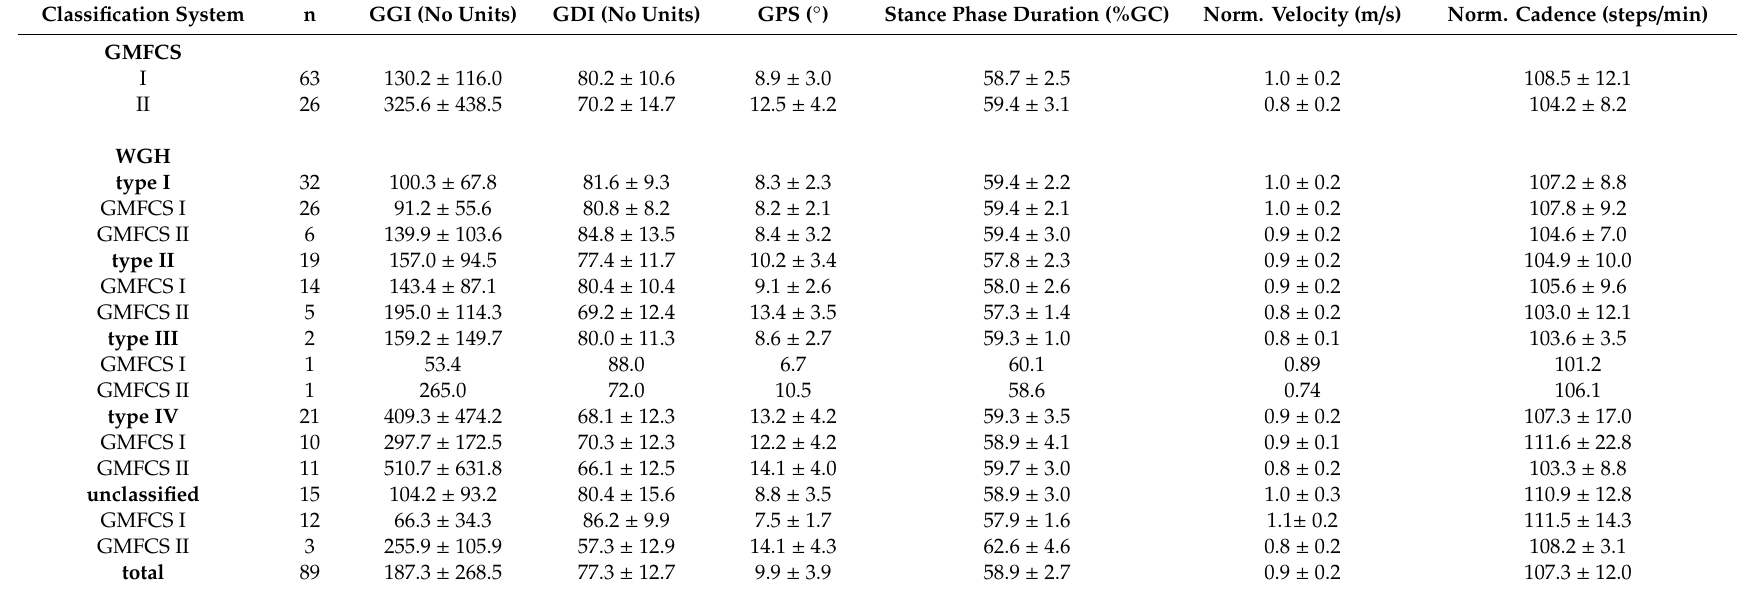
Table 1. Descriptive statistics. Subgroup-specific mean values of the di ff erent gait indices and mean spatiotemporal